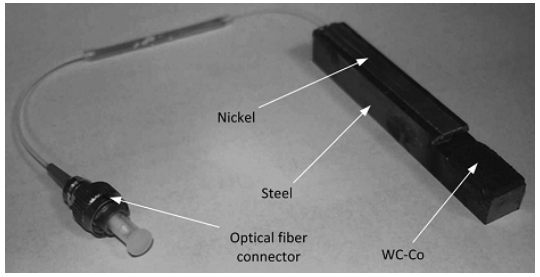
Figure 21. Prototyped sample with metal-embedded FBG using laser-assisted maskless microdeposition (LAMM) and electroplating [10].